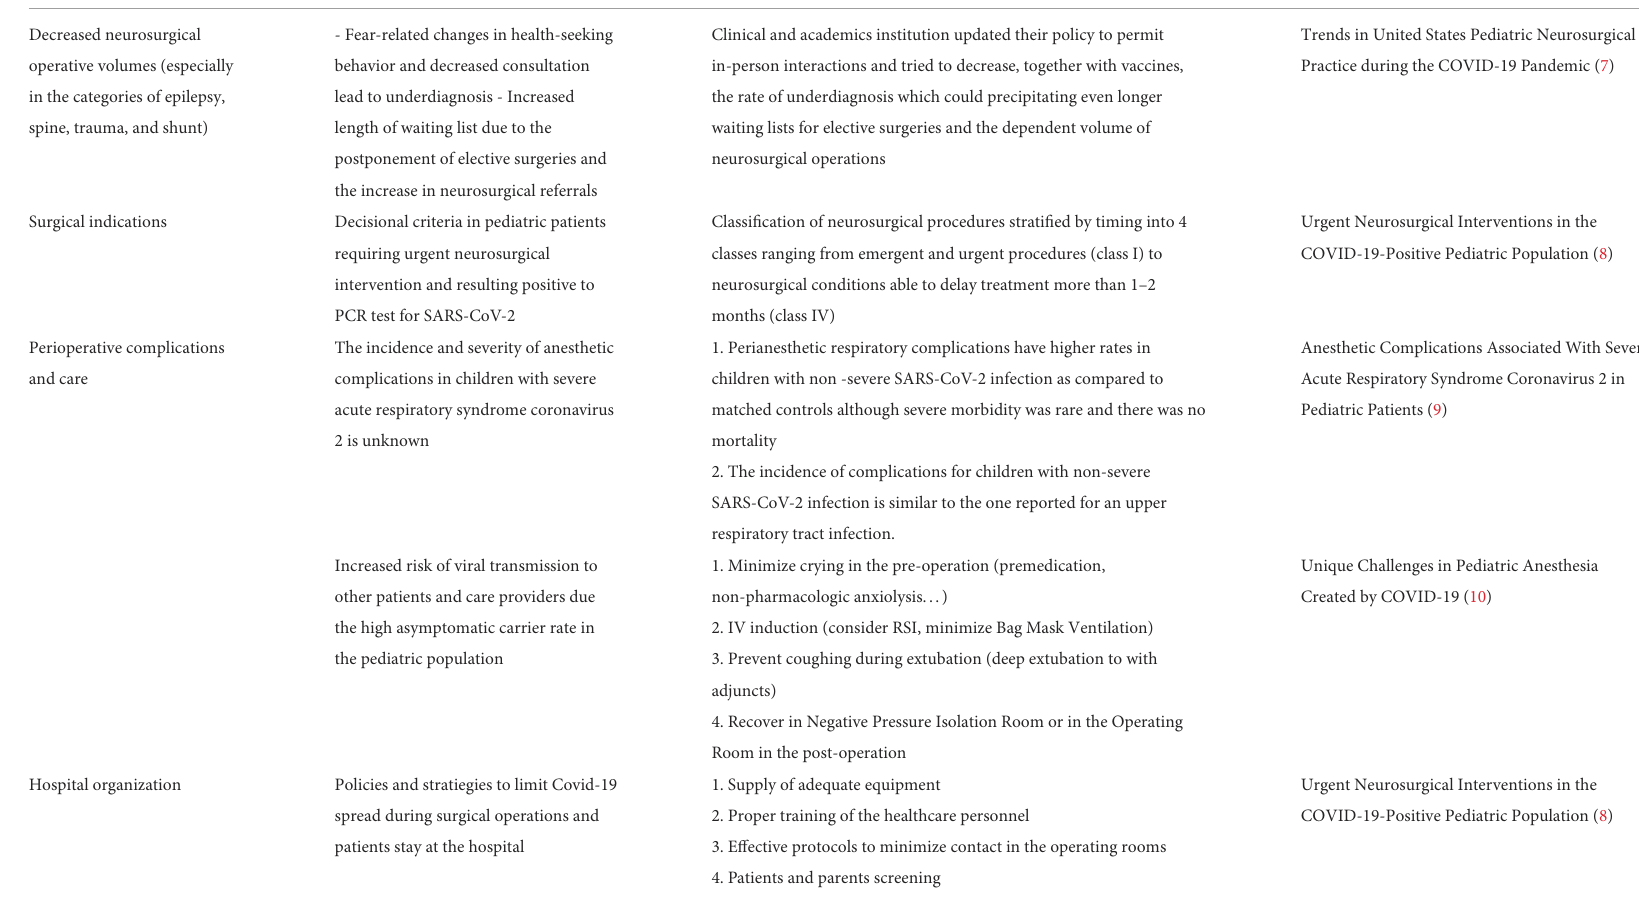
TABLE 1 Summary of the most important topics affected by COVID-19